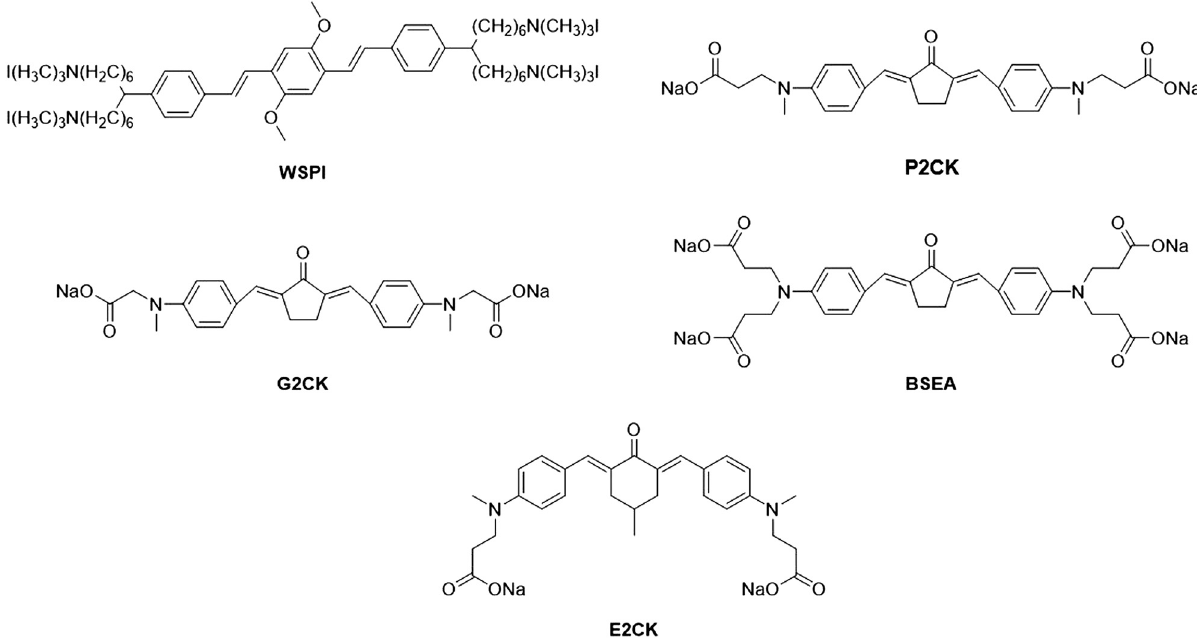
Figure 1: Molecular structures of water - soluble PIs for biomedical